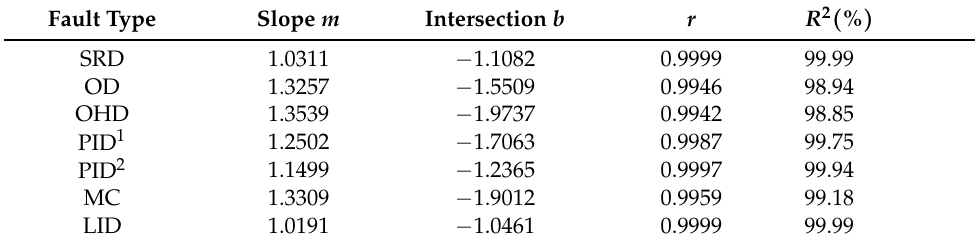
Table 6. Parameters of the best fit line equation for all fault